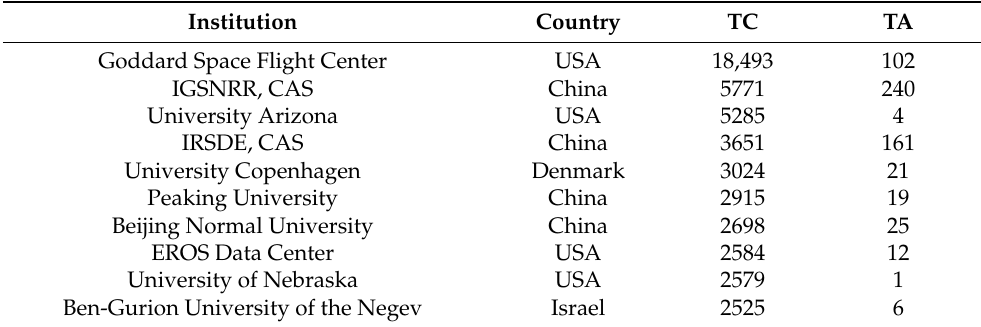
Table 3. Top ten institutions according to total number of citations in NDVI-related research.